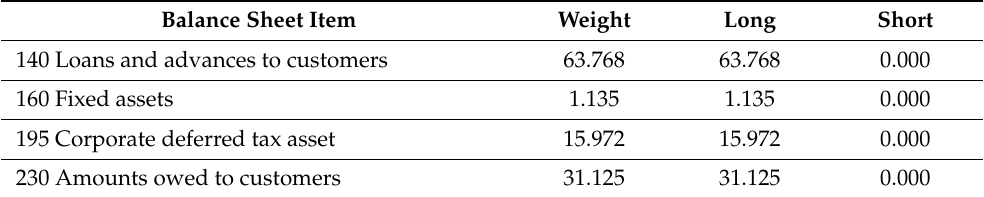
Table 4. Bank assets and liabilities, statistical data, forecast data.